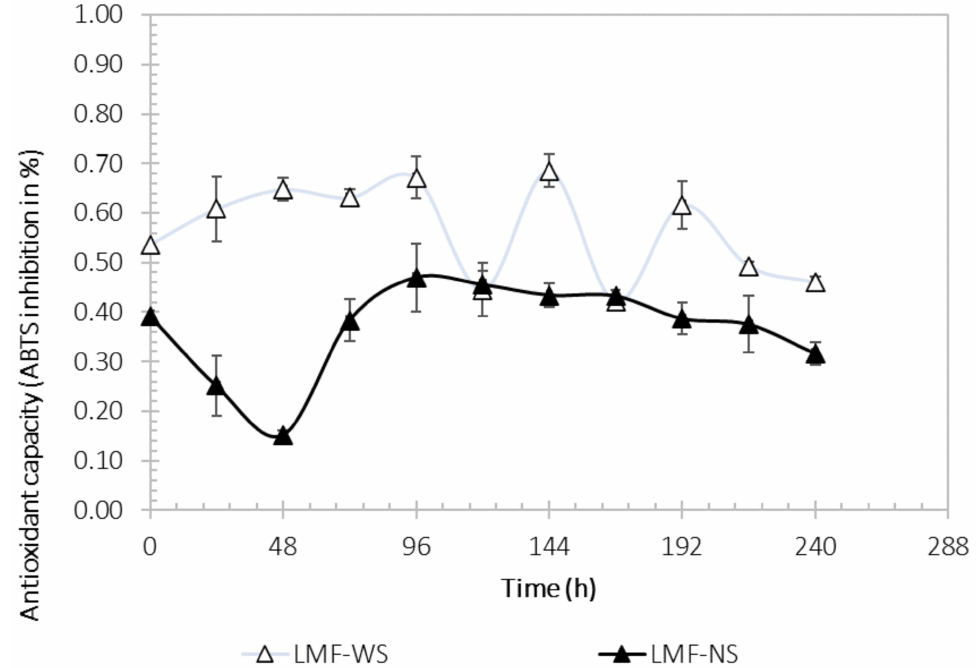
Figure 6. Antioxidant capacity during Aspergillus niger M4 Sargassum fermentation process, using washed Sargassum (light color) and natural Sargassum (solid color) as